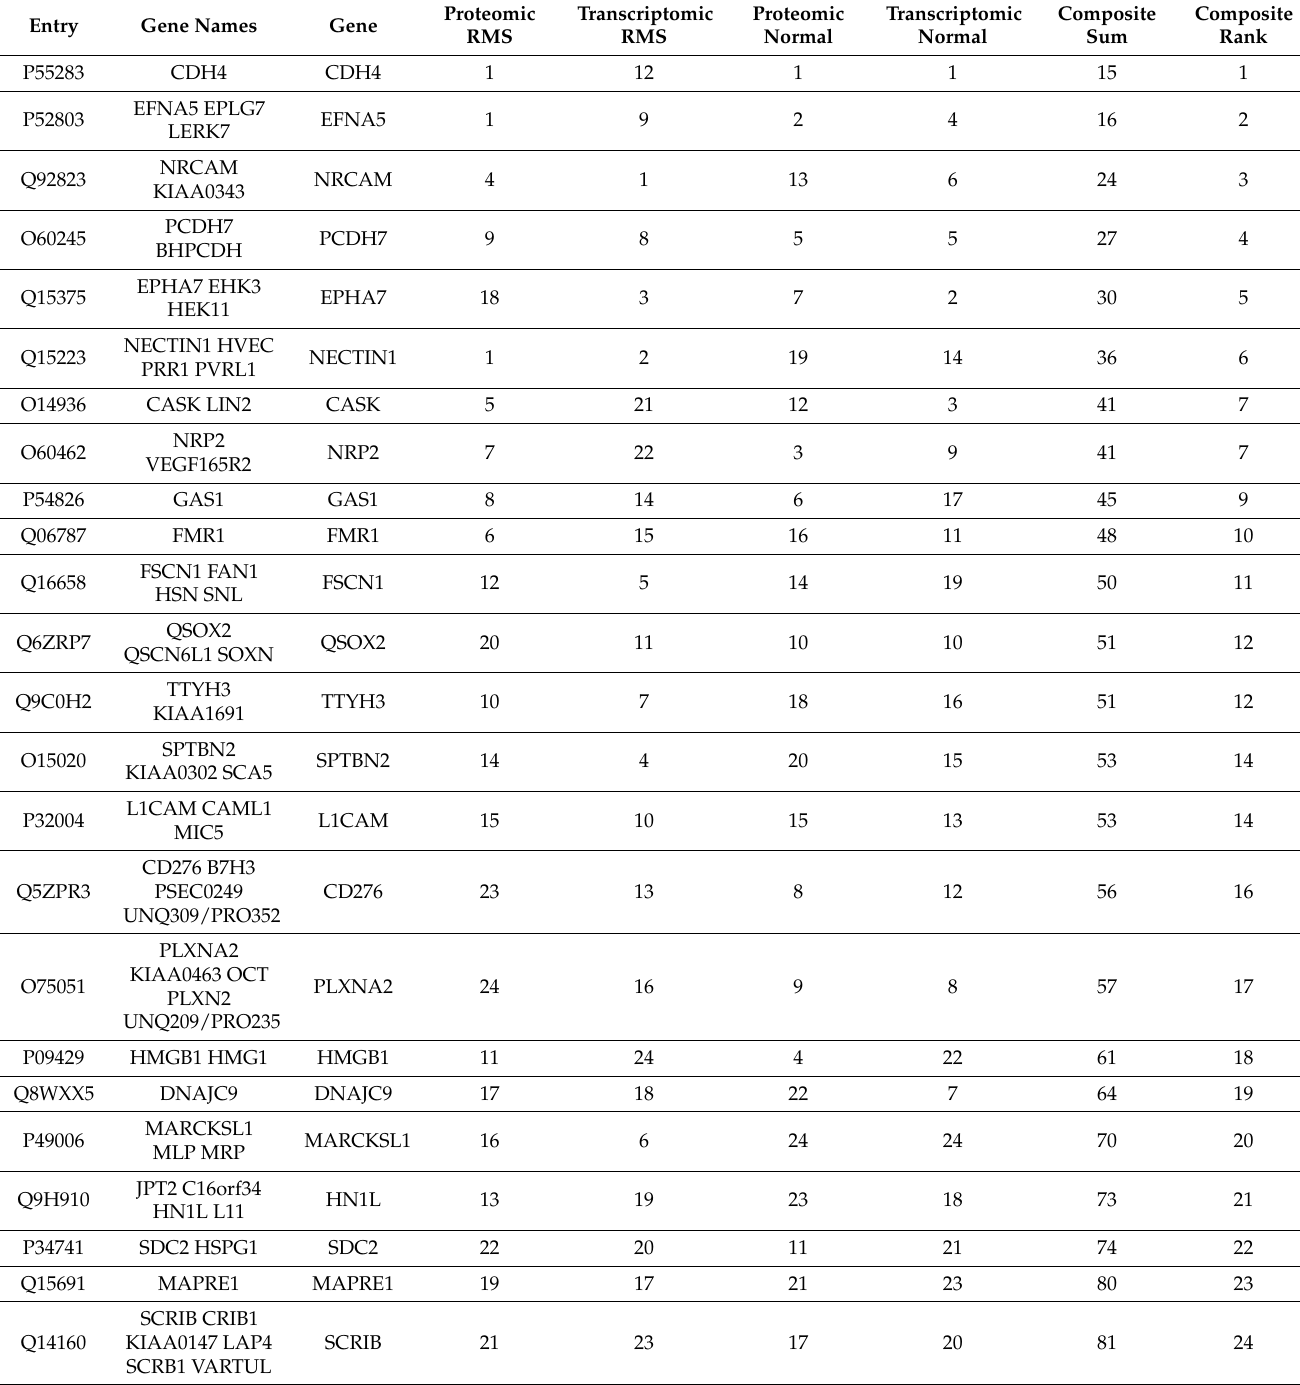
Table 1. Composite ranking of RMS-enriched cell-surface proteins based on combined transcriptomic and proteomic